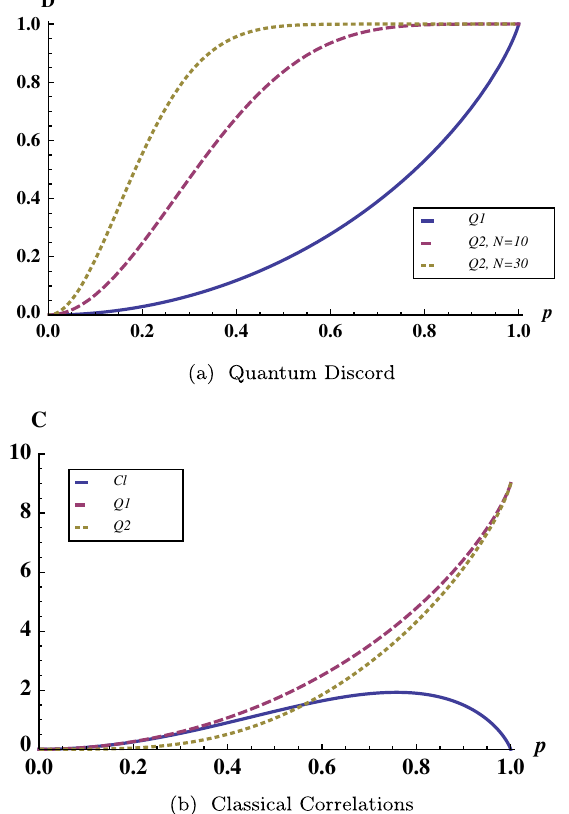
FIG. 4. Conjectured discord ( D ) and classical correlations ( C ) as functions of p . (a) Discord is always present for the two quantum strategies. Discord in Q 1 is independent of N . Entanglement is always (equal at p ¼ 1 or) smaller than discord and vanishes (for N ¼ 10 ) around p ¼ 0 : 118 for Q 1 and around p ¼ 0 : 088 for Q 2 . (b) Classical correlations for N ¼ 10 are plotted as function of the mixedness.